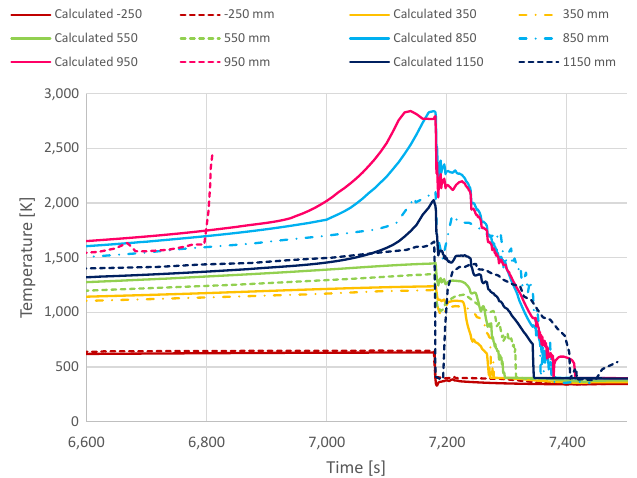
Fig. 2. Comparison of experimental and calculated temperatures for QUENCH-6 experiment of inner fuel rod surface temperature at different axial elevations. Continuous lines show values calculated in RELAP5/SCDAP, while dashed lines represent measured data in the experiment.